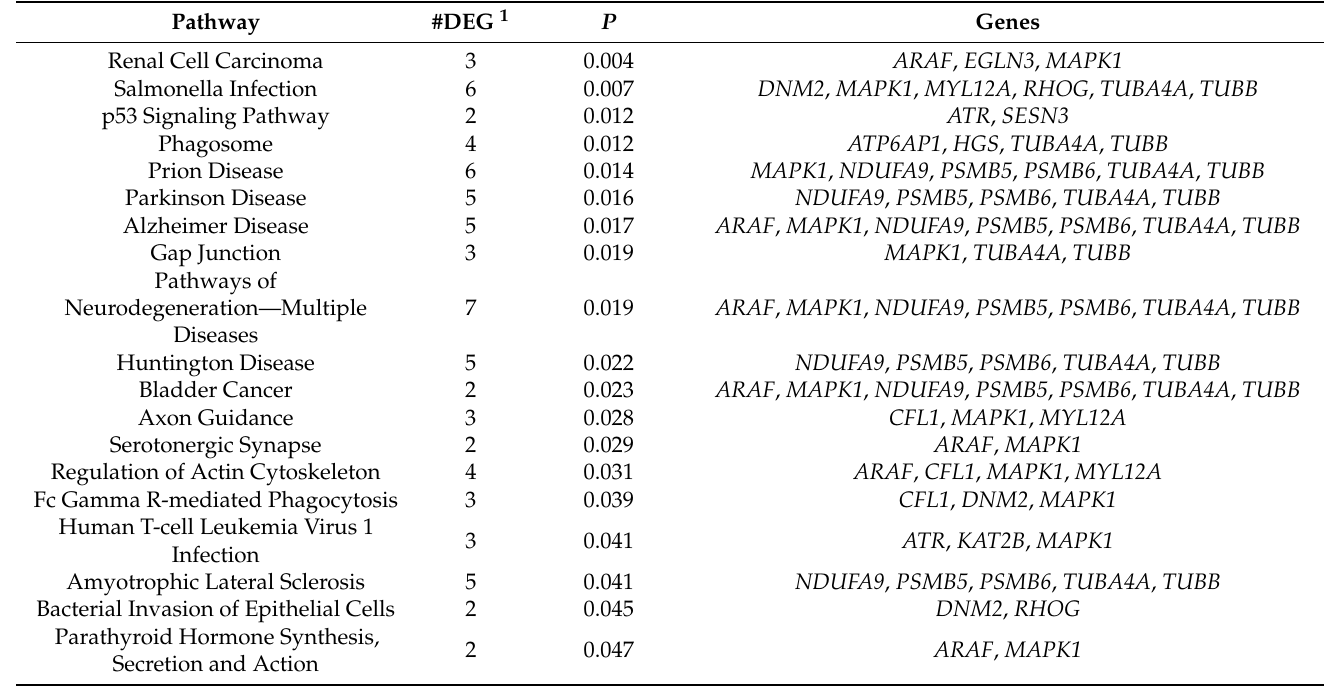
Figure 5. Pathways identified by iPathway Guide as over-expressed from the list of differentially expressed genes from the rumen tissue of two populations of steers with high and low RFI. Renal cell carcinoma (yellow) is shown, using negative log of the accumulation and over-representation p -values, along with the other most significant pathways. Pathways in red are significant based on the combined uncorrected p -values, whereas the ones in black are non-significant (where applicable). Table 2. Top pathways and their associated p -values identified by iPathway Guide as over-expressed from the list of differentially expressed genes from the rumen tissue of two populations of steers with high and low